Question: Generate an informative caption for the figure above.
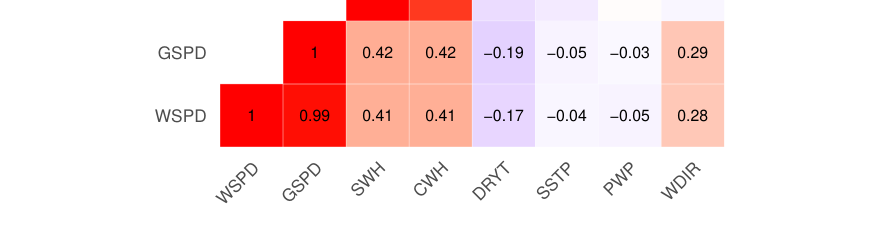
Answer: Heatmap showing the pairwise correlation across all variables in the data set.